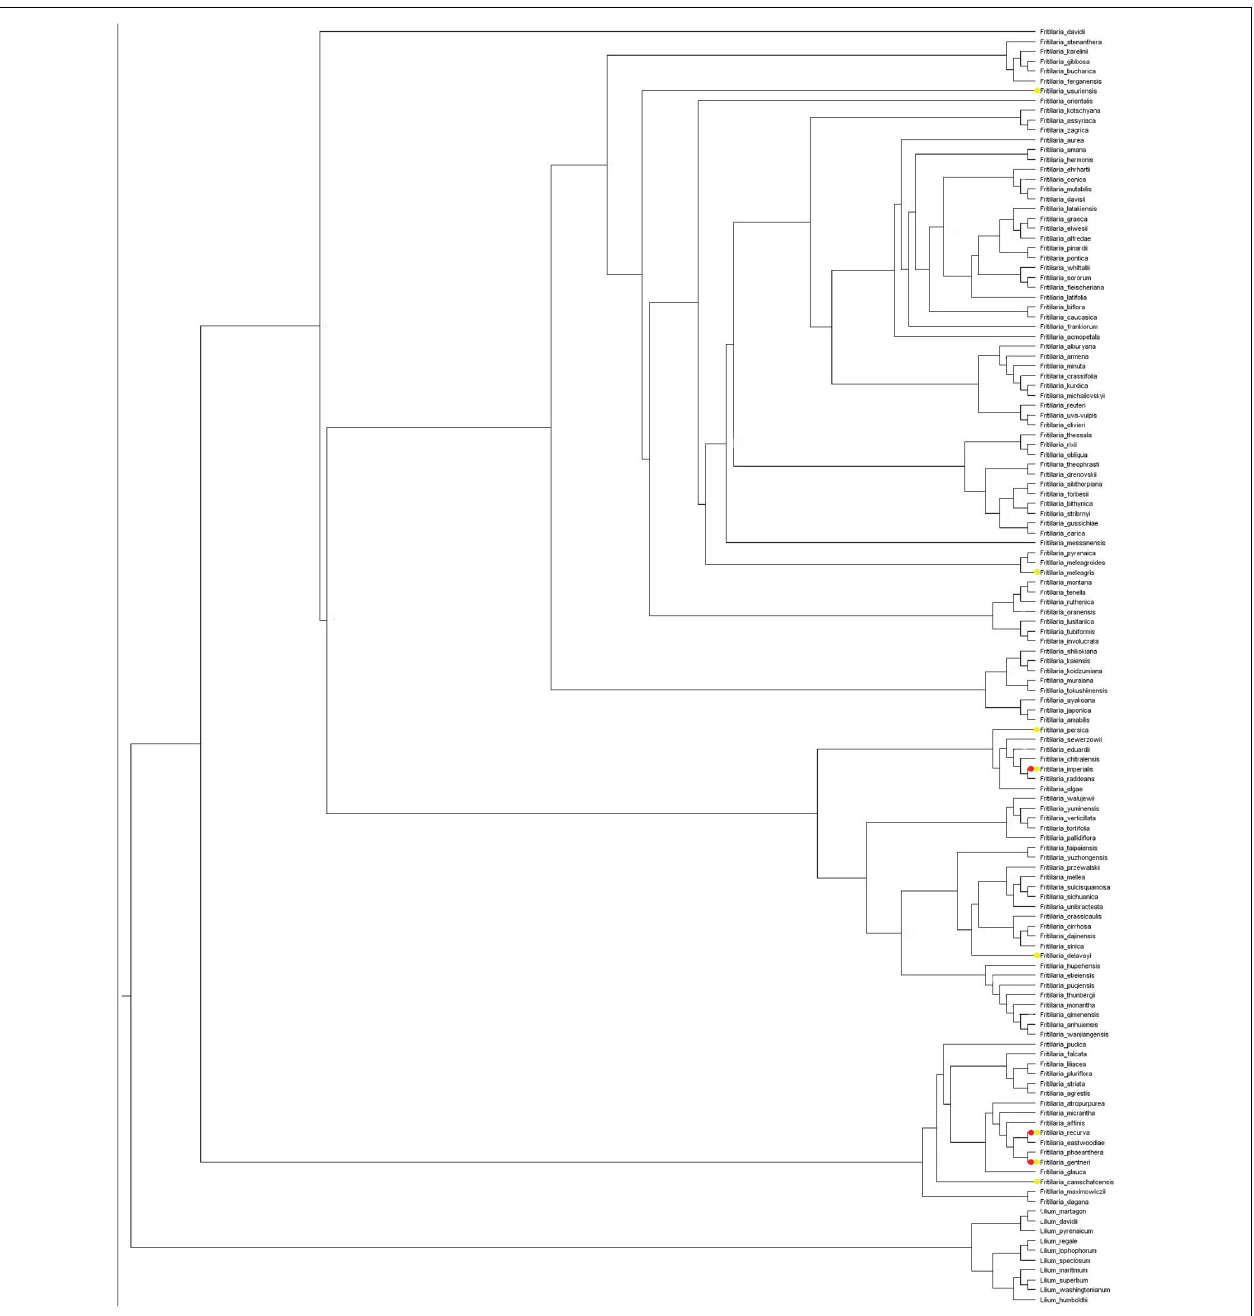
FIGURE 3 | Maximum likelihood tree showing available information about pollinators of Fritillaria flowers (based on the literature data). Species marked with yellow dot are described as pollinated by insects, with red dot are described as pollinated by insects and birds. For species with no colour sign information about pollinators are not